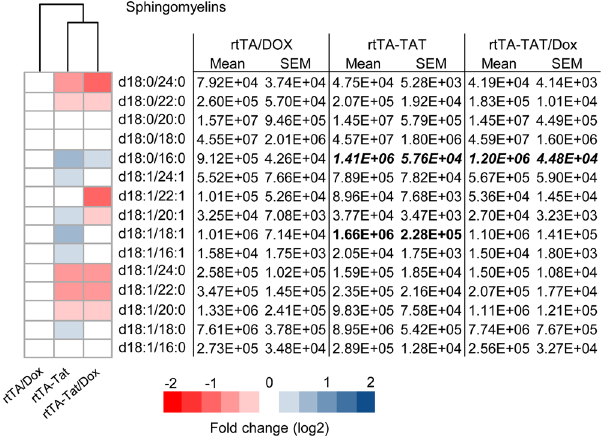
Figure 4. Accumulation of sphingomyelin in cortex of rtTA-Tat mice. Concentrations of sphingomyelins were determined in cortex of mice with the indicated genotypes. Hierarchal clustering analysis is shown to the left of each class of lipid. Blue colors indicates increase and red colors indicates decrease compared to rtTA control mice. Data are expressed as mean ± SEM, n = 6–7 per group. Bold text in table indicates p < 0.05 and italicized entries indicates p < 0.001 compared to rtTA control group. ANOVA with Tukey post hoc comparisons.